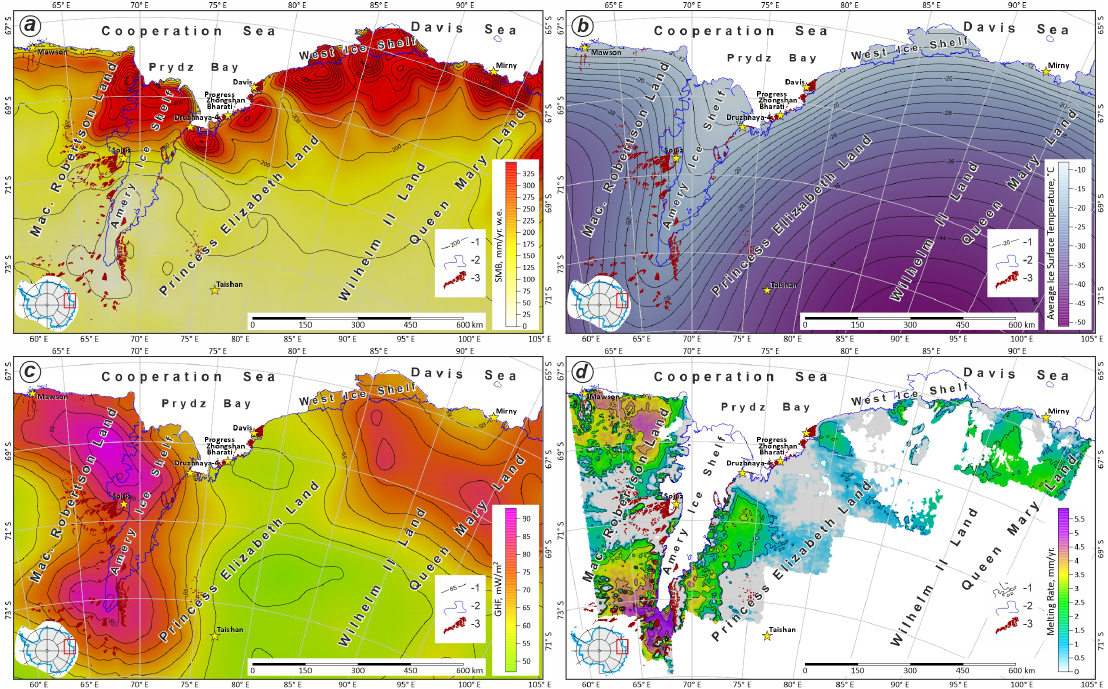
Figure 12. Accumulation rate ( a ), average ice surface temperature ( b ), geothermal heat flux ( c ), and bottom melting rate ( d ). 1—Contours of the maps (SMB, temperature, GHF, and bottom melting rate); 2—ice front and grounding line from [20]; 3—outcrops from